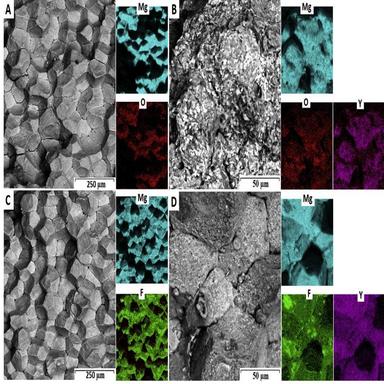
Fractography with EDS analysis of A) bare Mg, B) bare WE43, C) Mg-24h HF and D) WE43 24h HF.